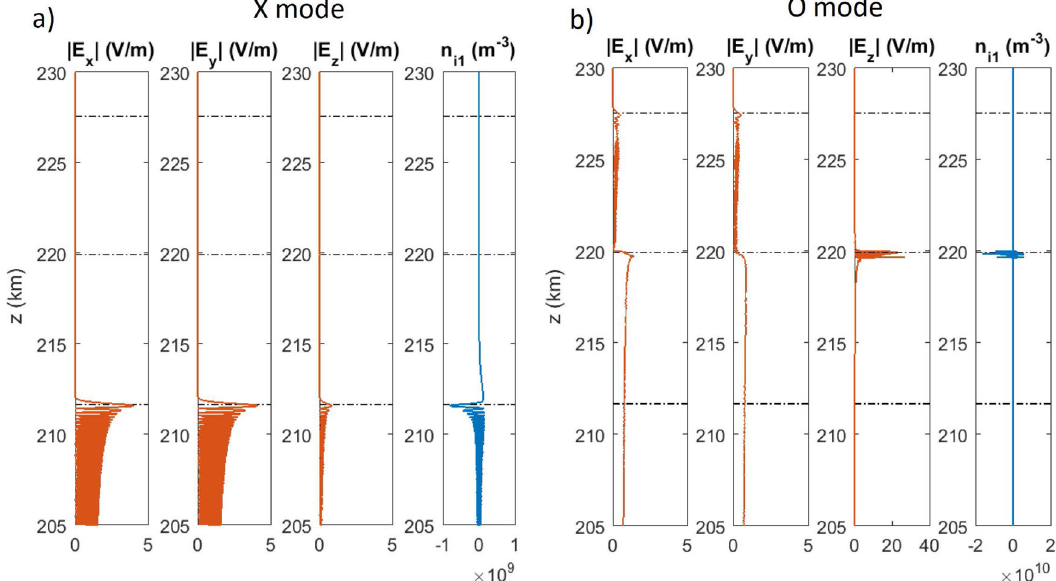
Fig. 6 Structure of wave electric fi eld and ion density fl uctuations at t = 10 s. One-dimensional simulation results at 10 s for transmitted waves having a X mode and b O mode polarization with frequency 6.3 MHz and injected amplitude 0.6 V/m at the bottom boundary. Shown are the amplitudes of the x , y and z components of the electric fi eld, and the ion density fl uctuations n i1 . Horizontal dash-dotted lines indicate the cutoff altitudes of the X, O, and Z mode waves at z ¼ 211 : 68km, 219 : 91km and 227 : 55km, respectively.